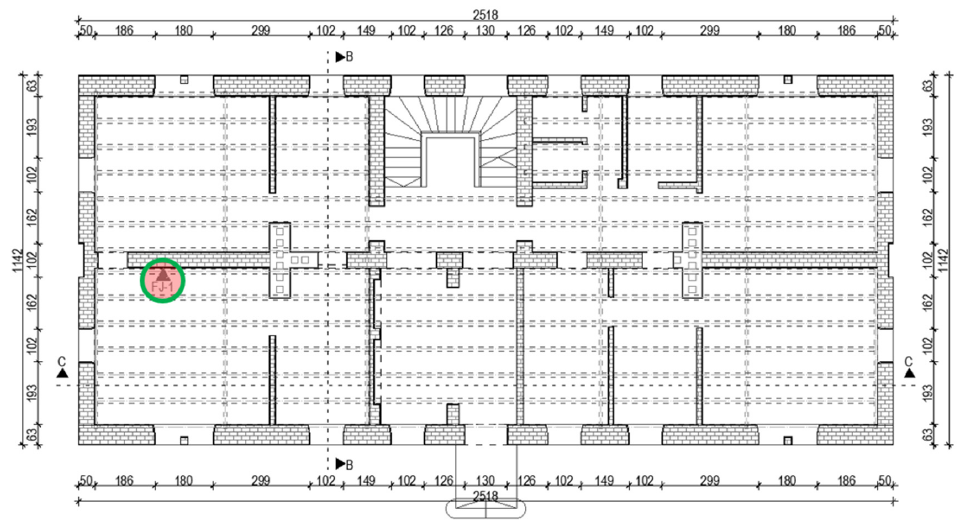
Figure 9. Ground floor plan with a marked test site.